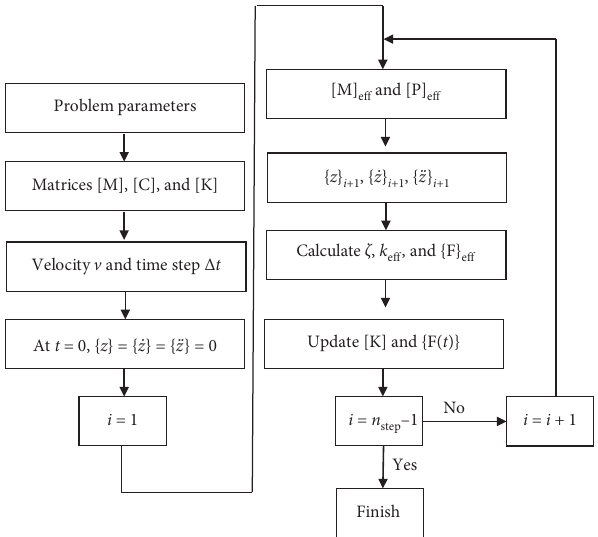
Figure 4: Flowchart for the numerical